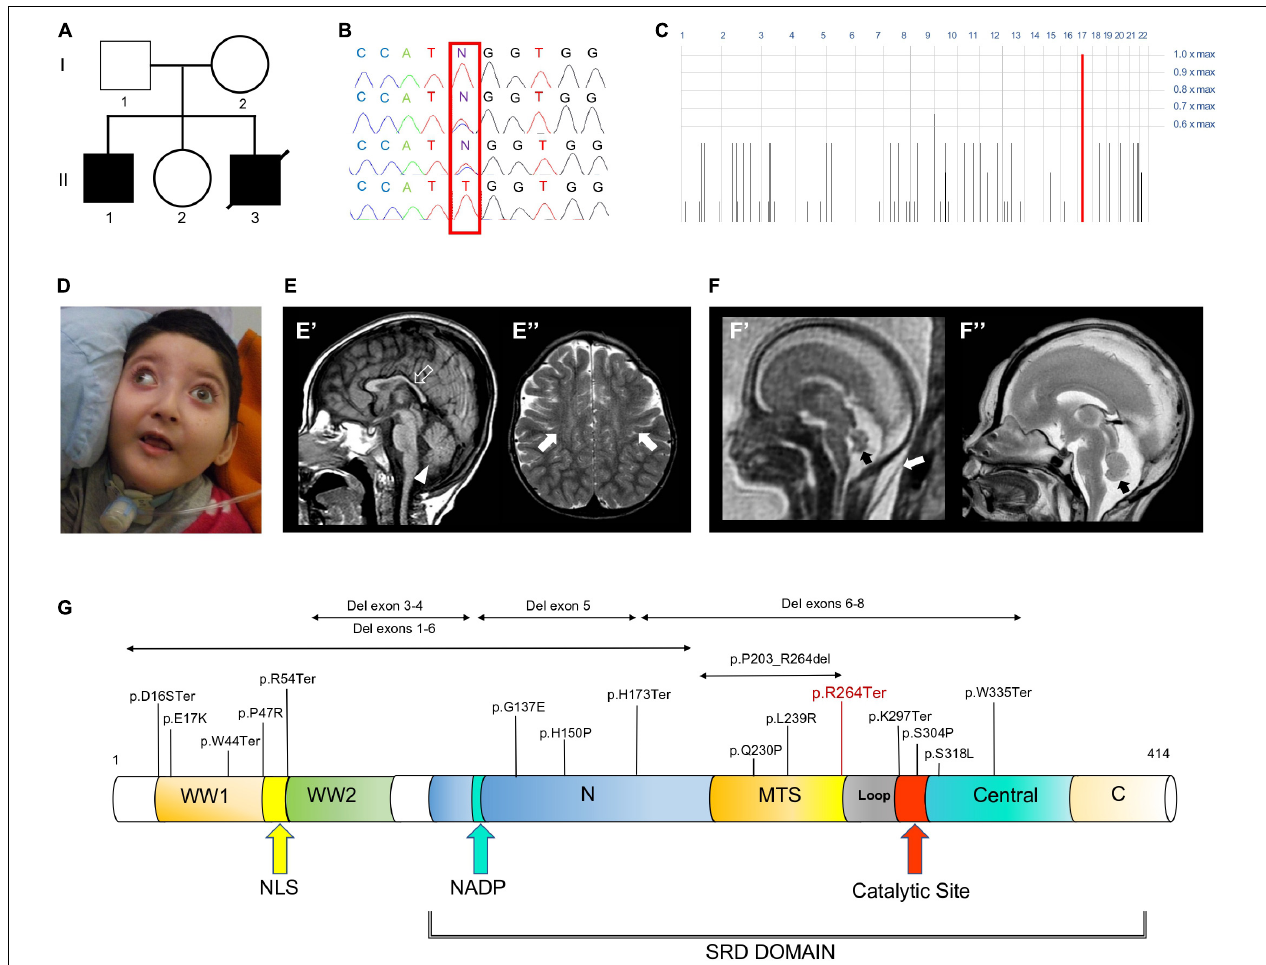
FIGURE 1 | Family tree, genetic studies, WOREE-associated clinico-radiological features, Wwox protein and WOREE-associated mutations. (A) Pedigree from Family. (B) Electropherograms of carrier parents and index case (II.1) with the c.790C > T homozygous variant introducing a p.Arg264Ter stop codon. (C) Homozygosity mapping reveal a homozygous bloc in the WWOX gene 16q23.2 region. (D) Distinctive craniofacial features in WOREE syndrome due to homozygous p.Arg264Ter variant, including round hypotonic face and short neck. (E) Brain MRI of Patient II.1 performed at 2.4 years of age. (E’) Sagittal T1-weighted image reveals hypoplasia of the corpus callosum (empty arrow) and inferior cerebellar vermis (arrowhead). (E”) Axial T2-weighted images demonstrates mild atrophy of the frontal lobes with associated bilateral white matter hyperintensity (arrows). (F) Fetal MRI (F’) and high-resolution post-mortem MRI (F”) studies of Patient II.3 performed at 21 gestational weeks demonstrate mild hypoplasia of the cerebellar vermis (black arrows). Note the slightly increased thickness of nuchal subcutaneous tissues on fetal MRI (white arrow). The laminar organization of the cerebral hemispheres and cortical gyration are appropriate for the gestational age (not shown). (G) Wwox protein structure and domains and WOREE-associated mutations identified so